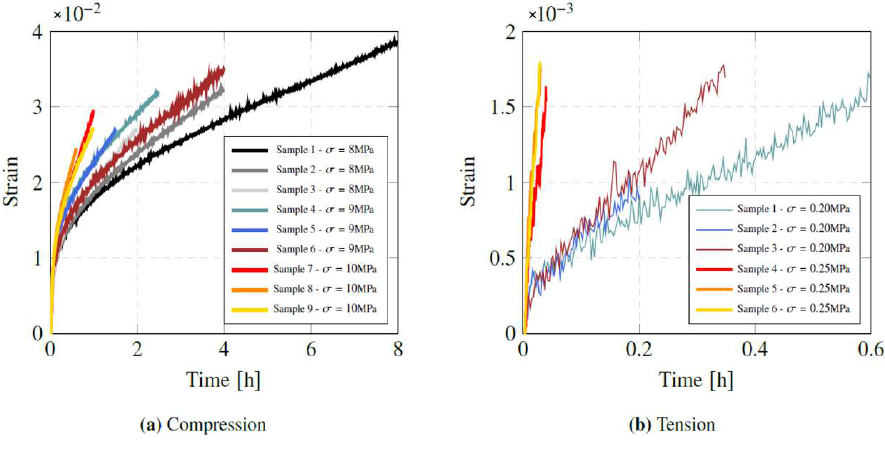
Figure 5. Creep tests at 1300 ◦